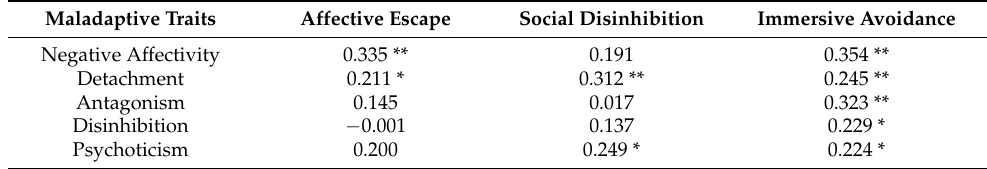
Table 2. Correlations between maladaptive personality traits and internet-related outcome expectan- cies in patients with internet-related disorders.